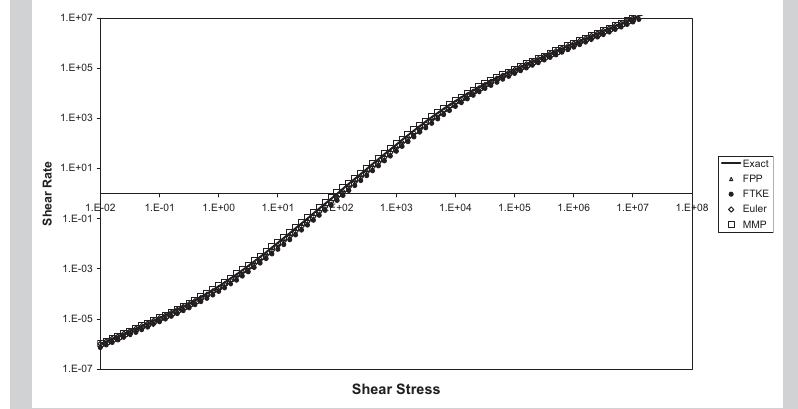
Figure 1: The recovery, from exact angular velocity data for a Couette rheometer with s = 0.7, of the flow curve (shear rate as a function of shear stress) for a Williamson fluid by the FPP, FTKE, Euler and MMP